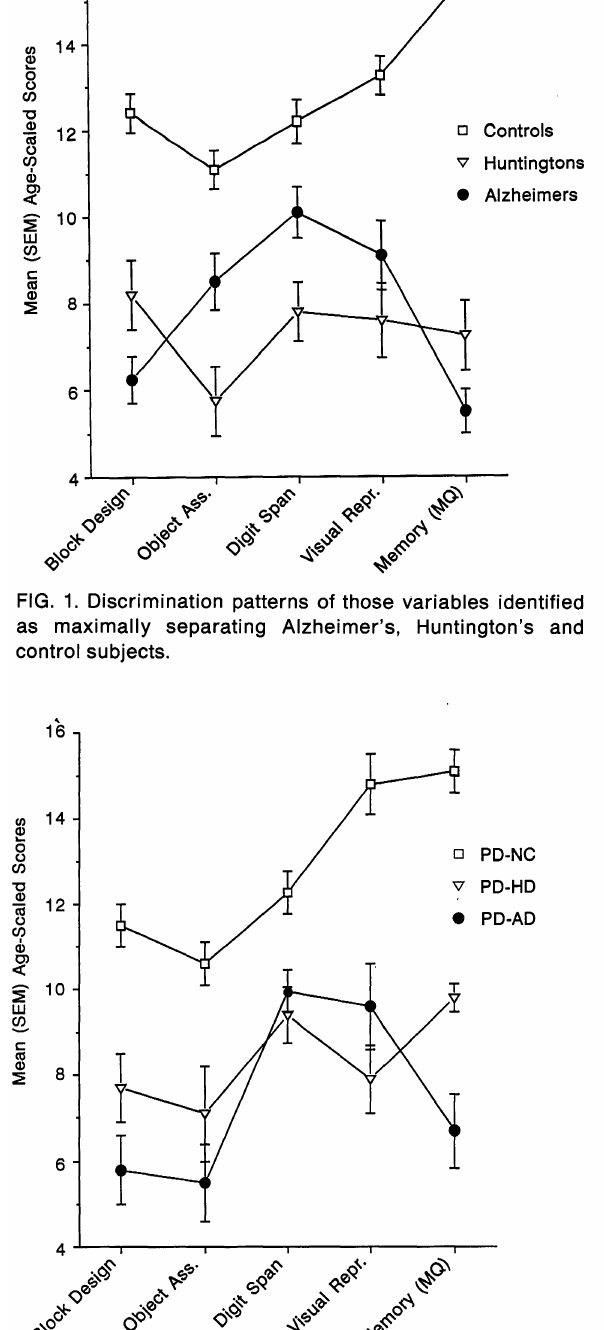
Block Design, Object Assembly, and Digit Span (WAIS-R subtests), as well as Memory Quotient 26 Behavioural Neurology. Vol 8 .